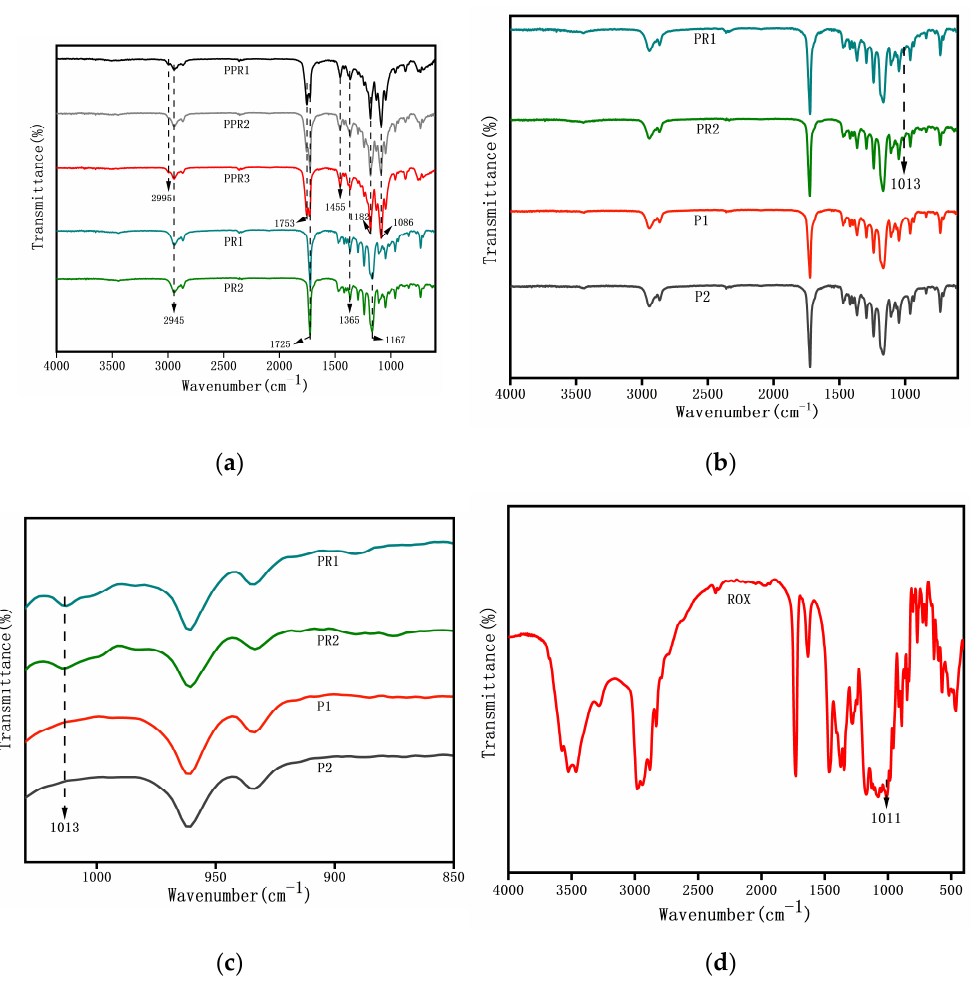
Figure 4. FTIR spectra of ( a – c ) drug-loaded nanofibers PPR1, PPR2, PPR3, as prepared by coaxial electrospinning; drug-loaded nanofibers PR1, PR2 and drug-free nanofibers P1, P2, as prepared by uniaxial electrospinning; and ( d ) ROX. Figure 4c is a partial enlargement of Figure 4d.